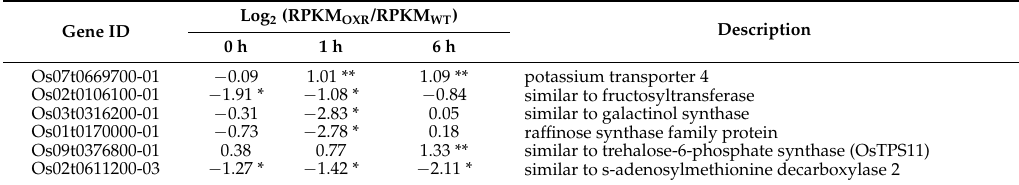
Table 2. List of DEGs related to osmotic adjustment under salt treatment.